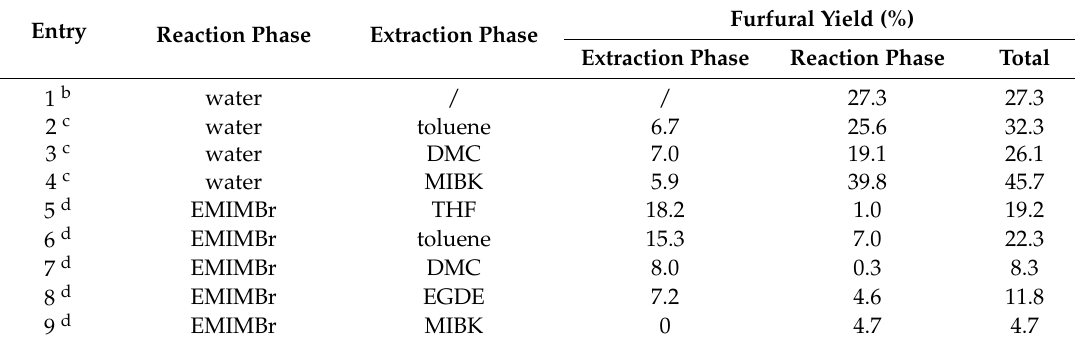
Figure 4. Effect of solvents on the dehydration of xylose into furfural. Reaction conditions: 200 mg of xylose was dissolved in 1000 mg of ionic liquid; molar ratio of SnCl 4 :xylose = 1:10; 130 °C; 1 h. Table 2. Effect of biphasic system on the conversion of xylose into furfural a .